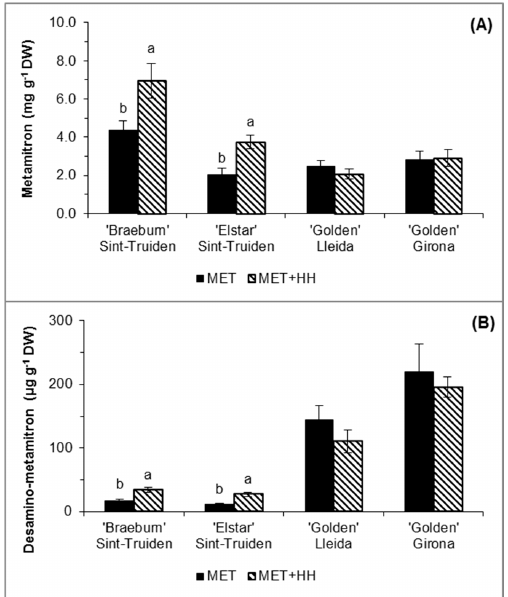
Figure 2. ( A ) Metamitron and ( B ) desamino-metamitron evaluated 2 days after spraying (DAS), in the trials with ‘Braeburn’ and ‘Elstar’ apples in Sint-Truiden, Belgium, and with ‘Golden Reinders’ apple in Girona and Lleida, Spain. For each parameter, the mean values ± SE ( n = 6) with different letters express significant differences between treatments within each cultivar/location using Tukey’s HSD test ( α -value ≤ 0.05). No letters indicate no significant difference between means.